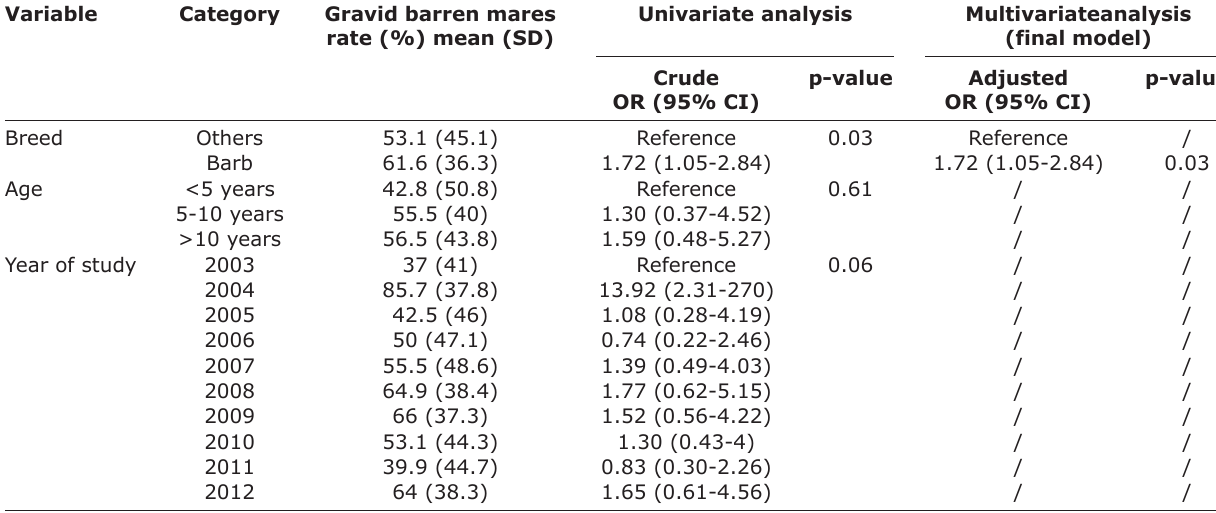
Table-2: Effect of the breed of the stallion on the number of barren mares become pregnant. Variable